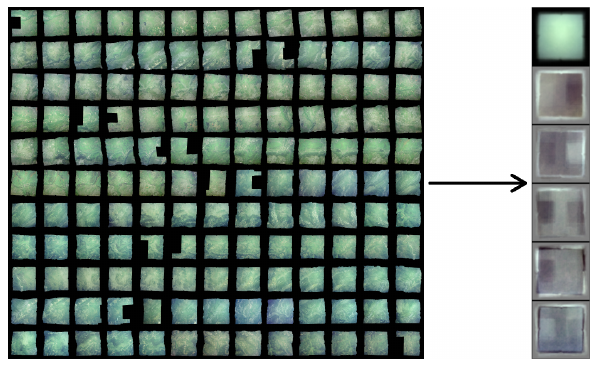
Figure 7. Six first eigen images from the KLT performed directly on the 143 images.